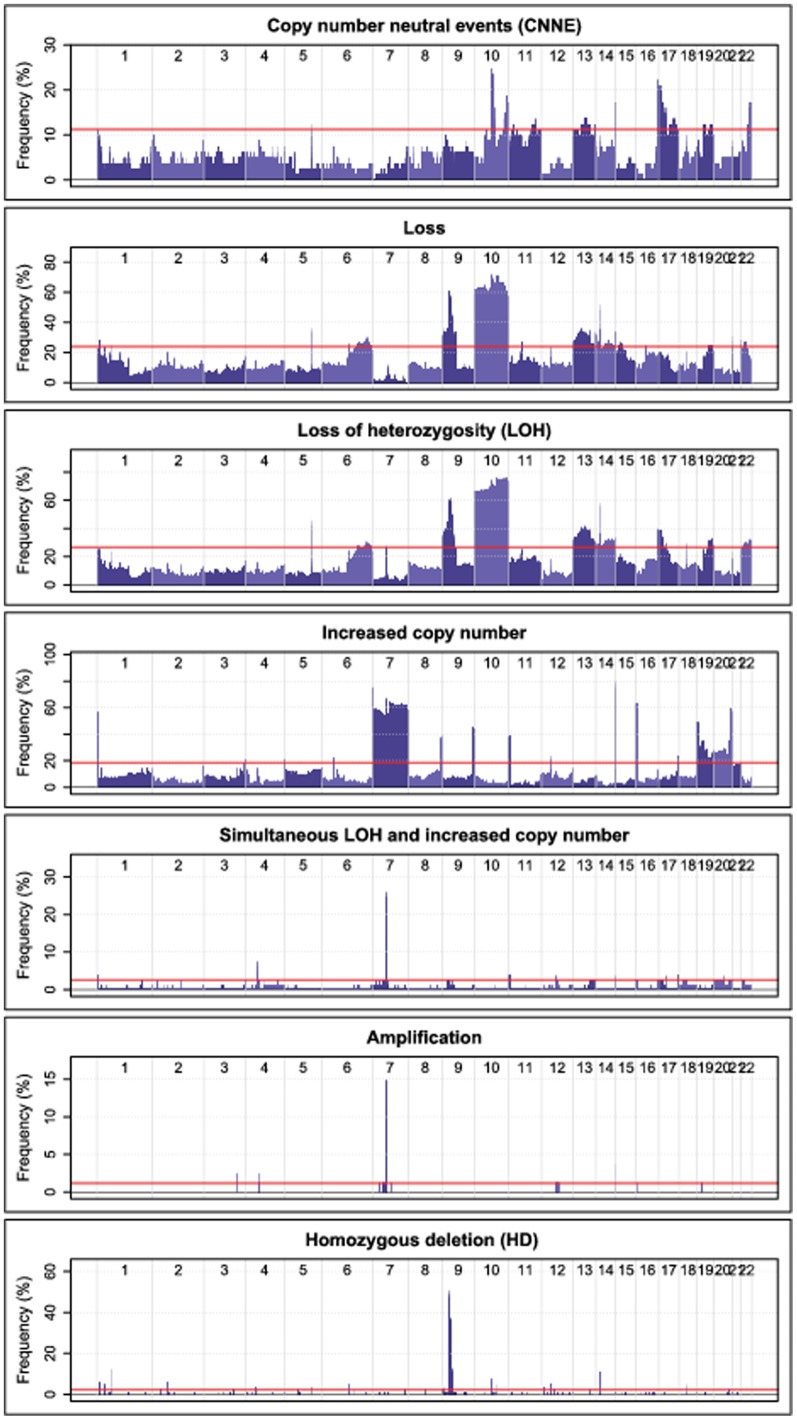
Frequency of genomic events among UMU samples.Frequency (%) is represented on the y-axis and genomic position on the x-axis. The permutation derived event frequency cutoff (used to establish regions with significantly recurring events among the UMU samples) is illustrated by the red line.